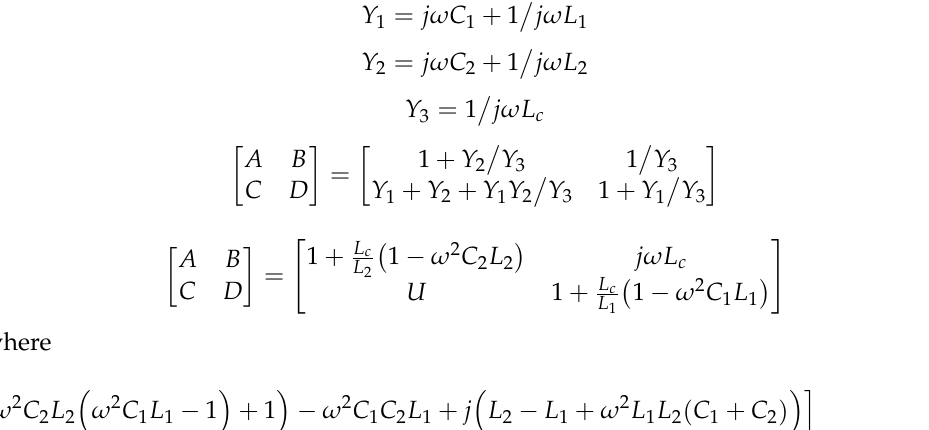
Figure 2. Simplified equivalent circuit model.